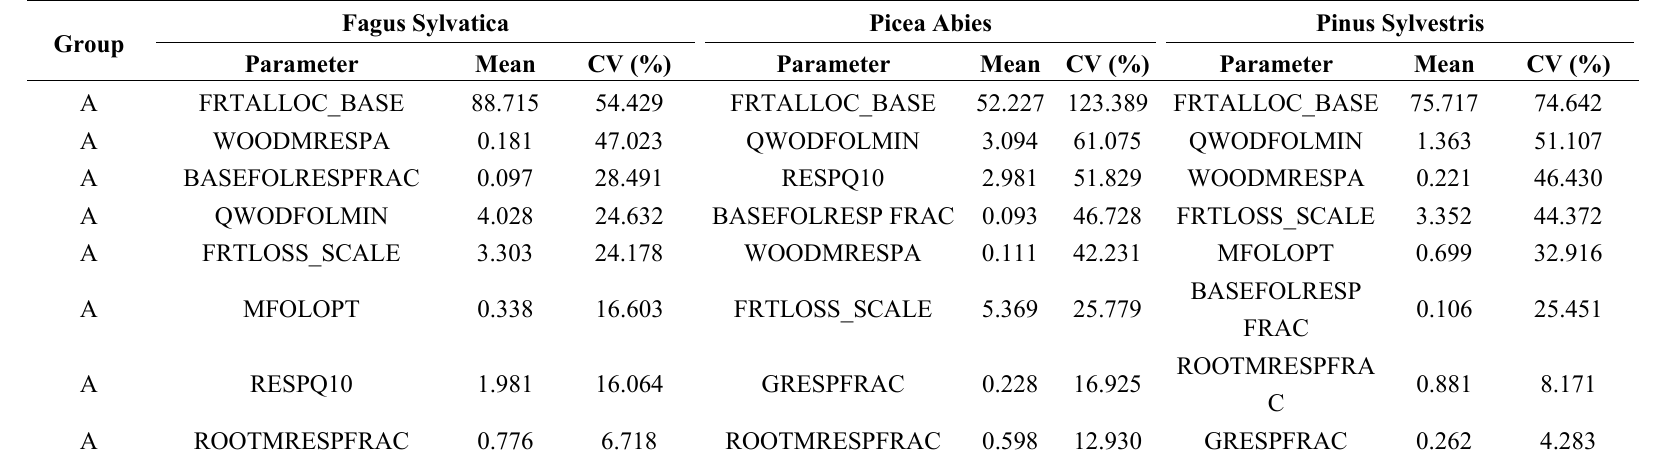
Table 3. Site-specific parameters per tree species. Parameters are grouped by allocation and respiration (A), nitrogen availability (N), temperature (T) and water availability and light extinction (W_L). The results are ordered from highest to lowest coefficient of variation